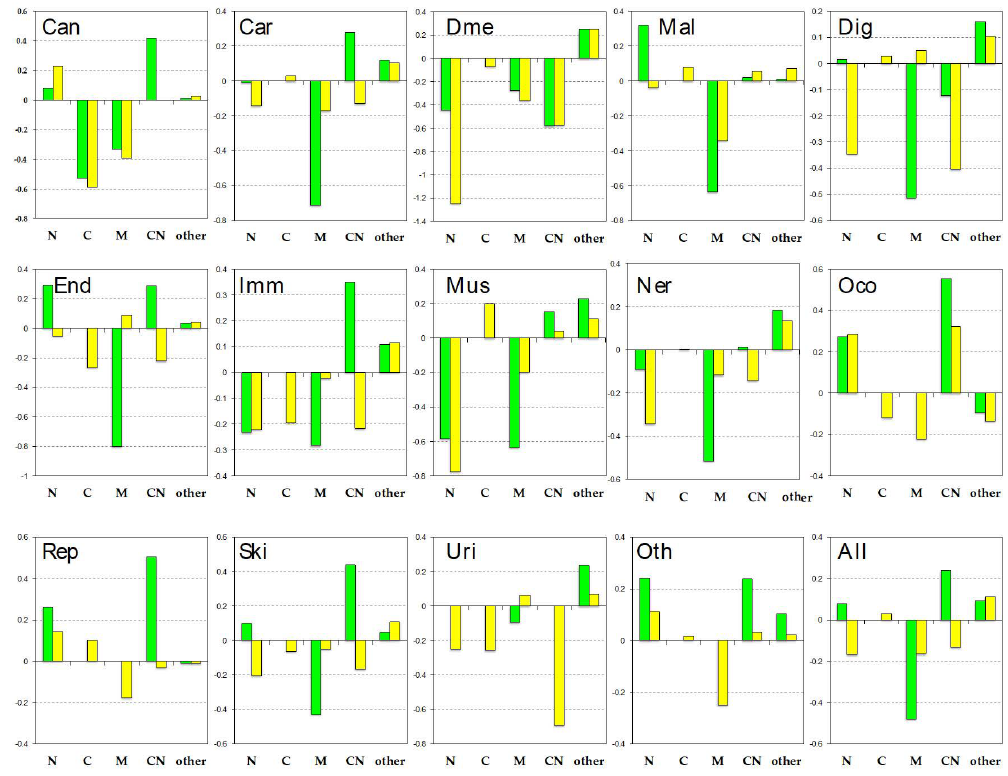
Figure 4. Subcellular localizations by disease category. The bars represent the degree of over-representation in each of the location categories, where green represents pProS-containing proteins, and yellow represents non-pProS proteins (see also Materials and Methods). N: Nuclear; C: Cytoplasm; M: Membrane; CN: Cytoplasm and nuclear; Can: Cancers; Car: Cardiovascular diseases;